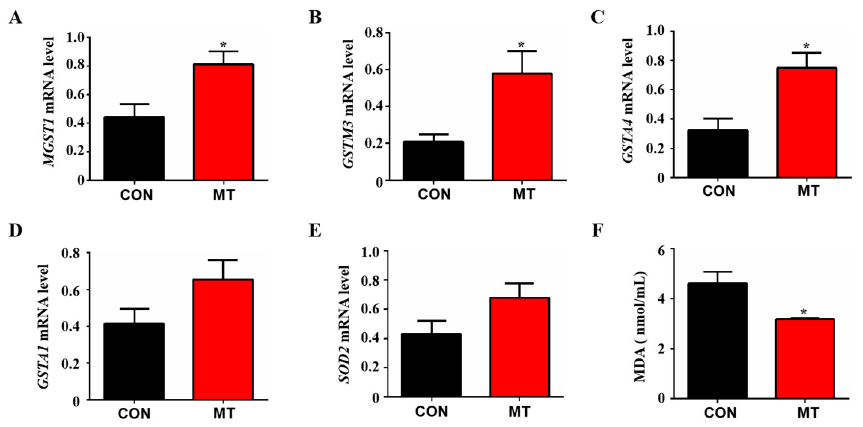
Figure 6. Effects of melatonin supplementation on the antioxidant capacity of placental tissue. ( A ) The mRNA expression levels of MGST1 ( n = 5). ( B ) The mRNA expression levels of GSTM3 ( n = 5). ( C ) The mRNA expression levels of GSTA4 ( n = 5). ( D ) The mRNA expression levels of GSTA1 ( n = 5). ( E ) The mRNA expression levels of SOD2 ( n = 5). ( F ) MDA concentration in peripheral blood ( n = 3). Data are presented as means ± SEM. * p < 0.05. CON = control, MT =